Question: According to this chart, does the measure grow or shrink?
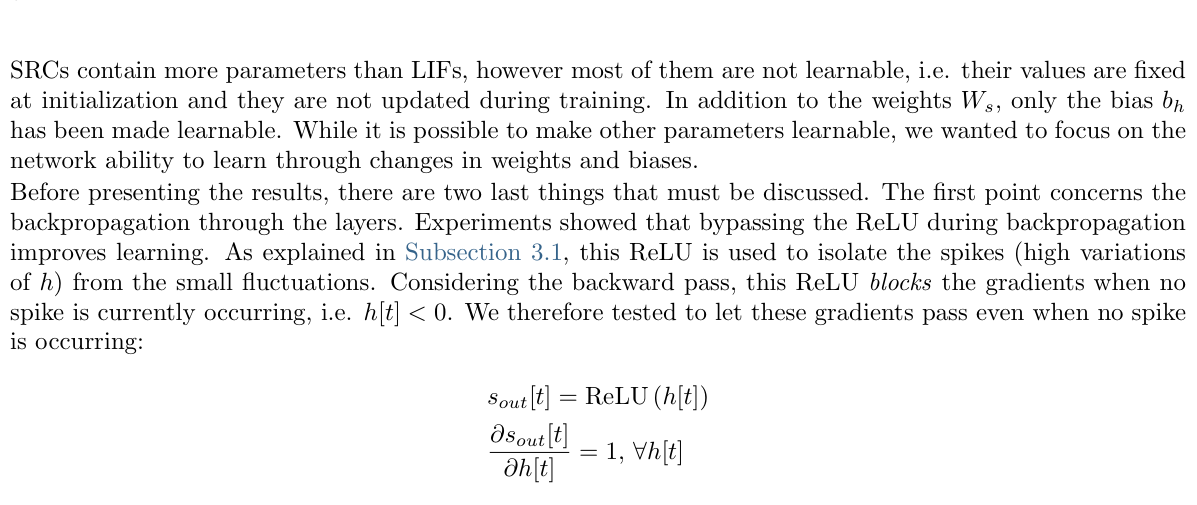
Answer: increasing